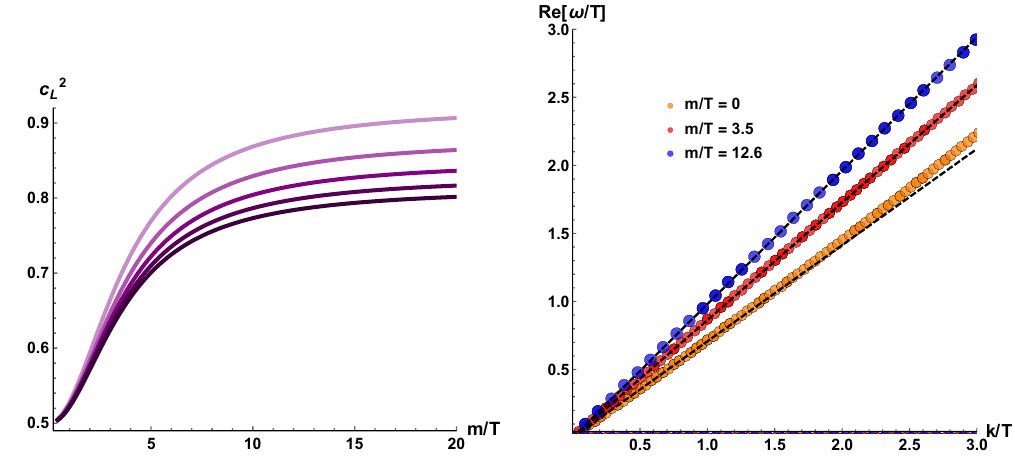
Figure 5 . Left: longitudinal phonons speed for various potentials N = 3 ; 4 ; 5 ; 6 ; 7 ; 8 (from lighter to darker color) in function of the dimensionless parameter m=T . Right: real part of the dispersion relation of the longitudinal phonons for the potential N = 3 and various m=T 2 f 0 ; 3 : 5 ; 12 : 6 g . The dashed black lines are the comparisons with the theoretical formula (3.7); the agreement is